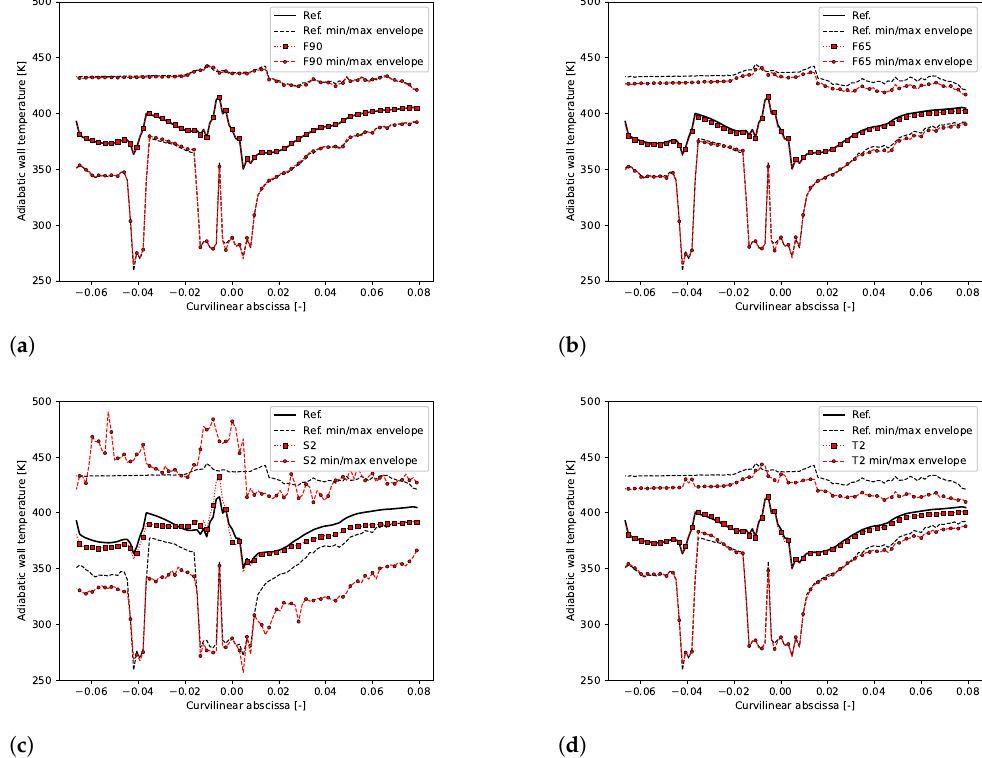
Figure 21. Evolution of the average adiabatic wall temperature (temporal average and averaged along the radial direction) along the curvilinear abscissa of blade #2 with the envelope of minimum and maximum values. The zero of the curvilinear abscissa corresponds to the blade leading edge. Negative values correspond to pressure side and positive values to the suction side ( a ) F90. ( b ) F65. ( c ) S2. ( d ) T2.